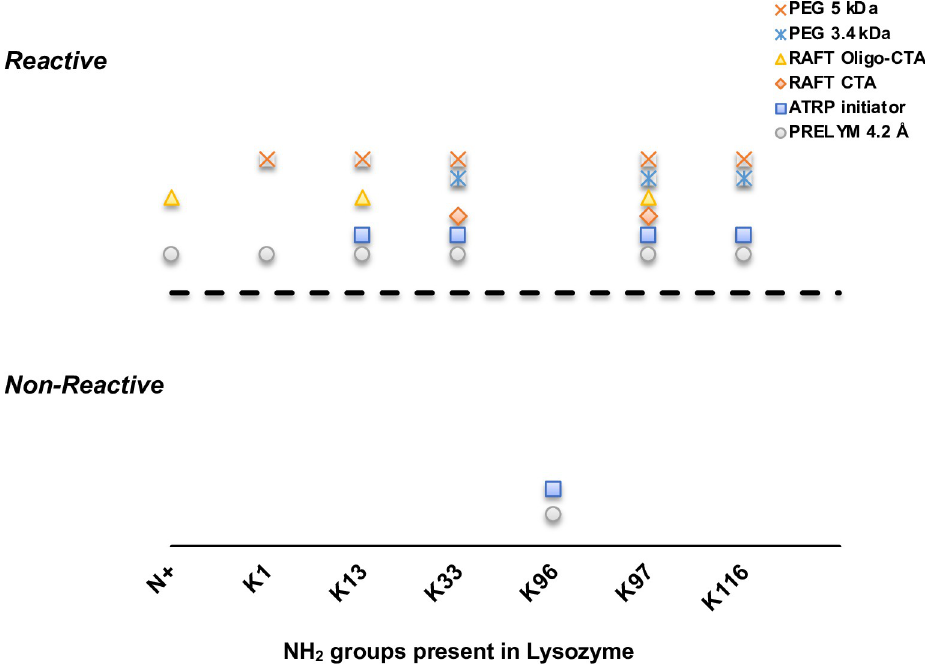
Fig 4. Comparison of PRELYM results using a 4.2 Å probe size with confirmed amine sites after modification with ATRP initiator [14], diethylene glycol [35] or oligomeric RAFT CTA [36], and PEG 3.4 [42] or 5 kDa [43, 44]. Overall classification of reacting and non-reacting residues in PRELYM agreed strongly with experimental findings.